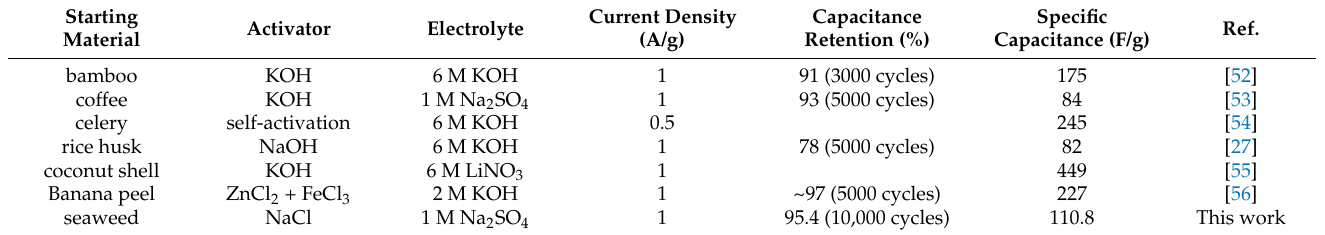
Table 8. Comparison of electrochemical performance of carbon from other biomass in the